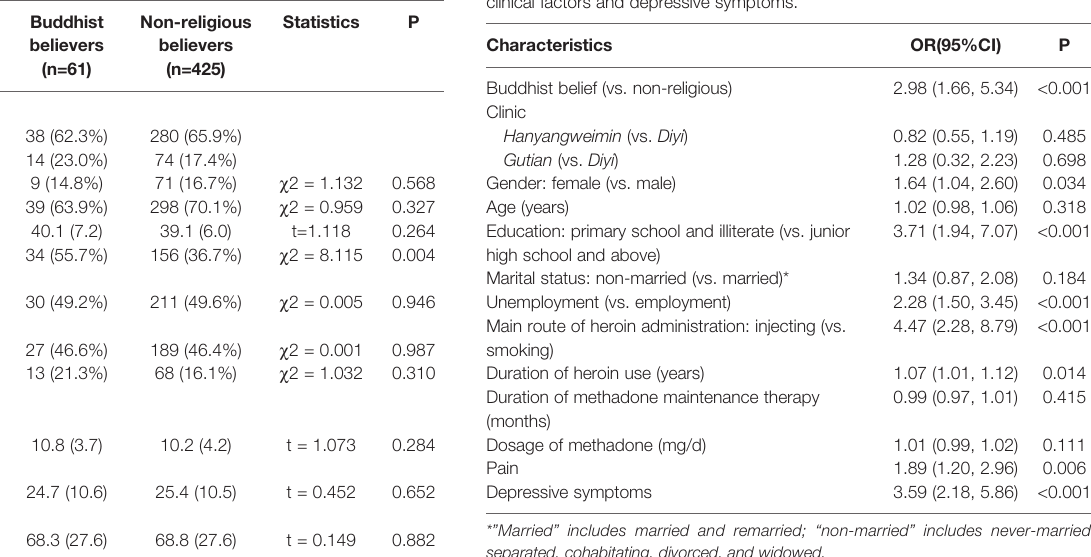
TABLE 1 | Characteristics and current suicide risk of Buddhist and non-religious believers among Chinese persons receiving methadone maintenance therapy (MMT) for heroin